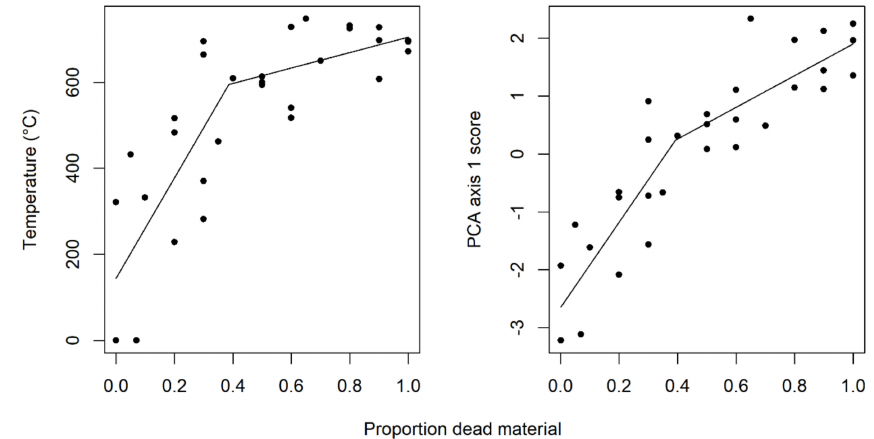
Figure 4. Piecewise regression models for combustibility (temperature ( ◦ C)) and overall flammability (PCA axis 1 scores). The breakpoint in both models is at a dead material proportion of